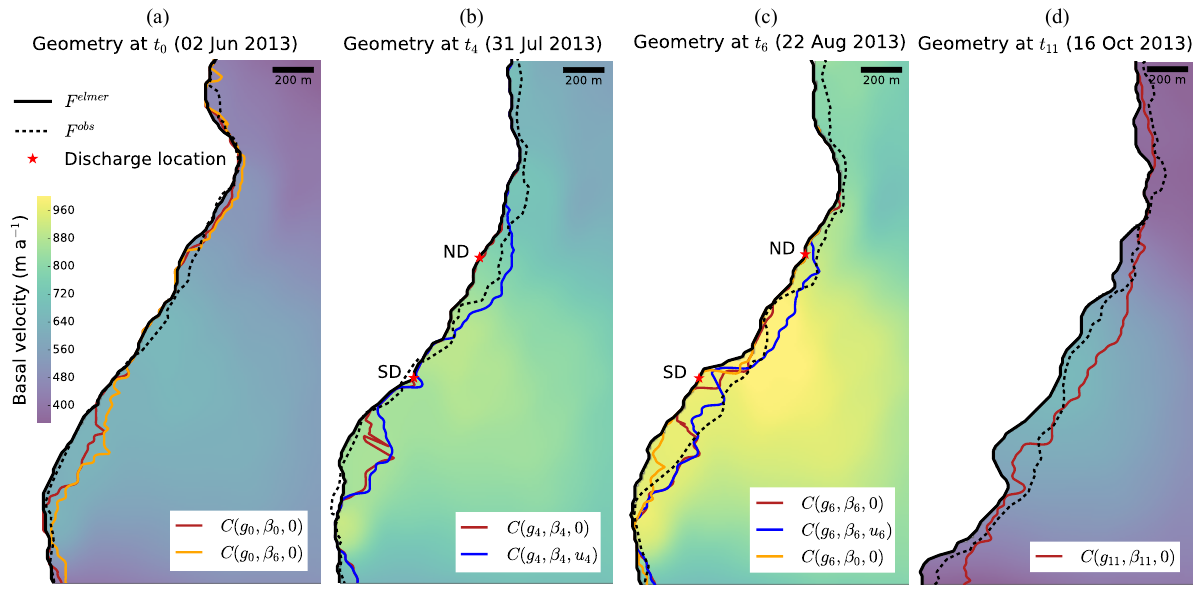
Figure 10. Basal velocity, advanced front before calving modelled with Elmer/Ice, F elmer F obs , in dashed black; and calving front modelled with HiDEM, F hidem i (a) i = 0, (b) i = 4, (c) i = 6, and (d) i = 11. Discharge locations (for i = 4 , 6) are marked with a red